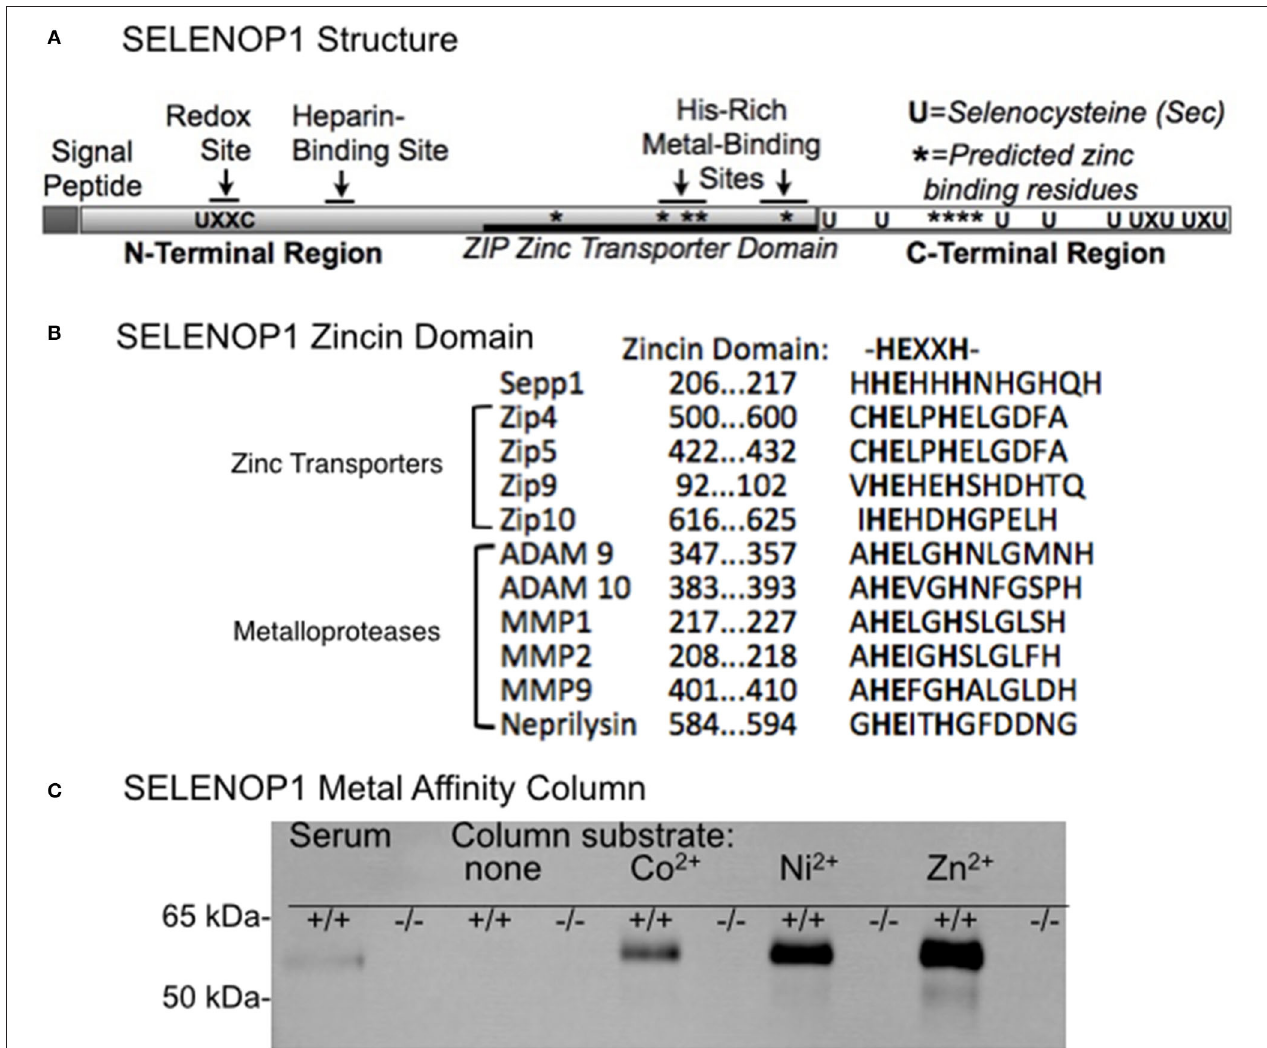
FIGURE 1 | Zinc-binding properties of SELENOP1. (A) Schematic of SELENOP1 structure. The N-terminal region has 1S (U) in a redox domain, a heparin-binding site and a zinc transporter domain with two metal-binding sites. The C-terminal region has 9S residues for Se transport. Sites of residues predicted to bind zinc using Predzinc are indicated by *. (B) Alignment of human SELENOP1 metal binding region with other proteins containing the zincin motif. (C) Western blot of metal column eluates after applying mouse serum from WT ( + / + ) or SELENOP1 KO ( − / − ) mice to mini columns with agarose only or agarose bound to Co 2 + , Ni 2 + , and Zn 2 + . Untreated SELENOP1 − / − and WT serum were also added to the blot as a positive control (left lanes). SELENOP1 protein detected with anti-SELENOP1 antibody (1:1000) had a molecular weight of approximately 55 kDa in the wildtype serum, which was not seen in SELENOP1 − / − serum. SELENOP1 was detected in column eluates from wild-type serum applied to all metal columns, but not from columns with agarose